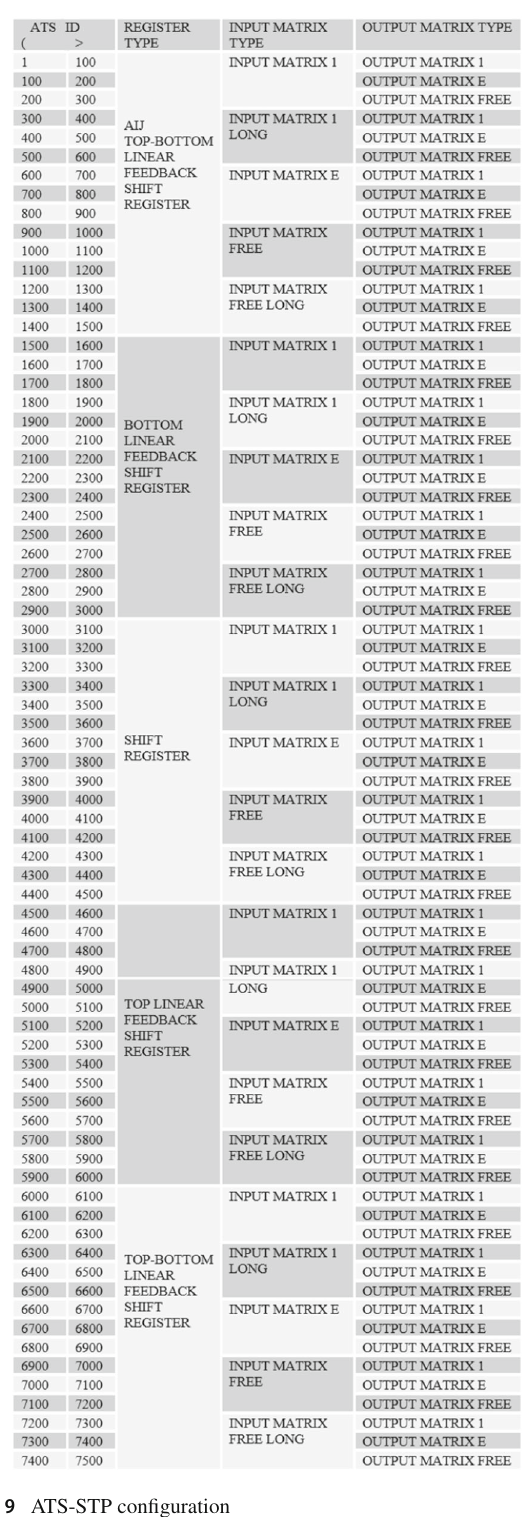
Fig. 9 ATS-STP configuration